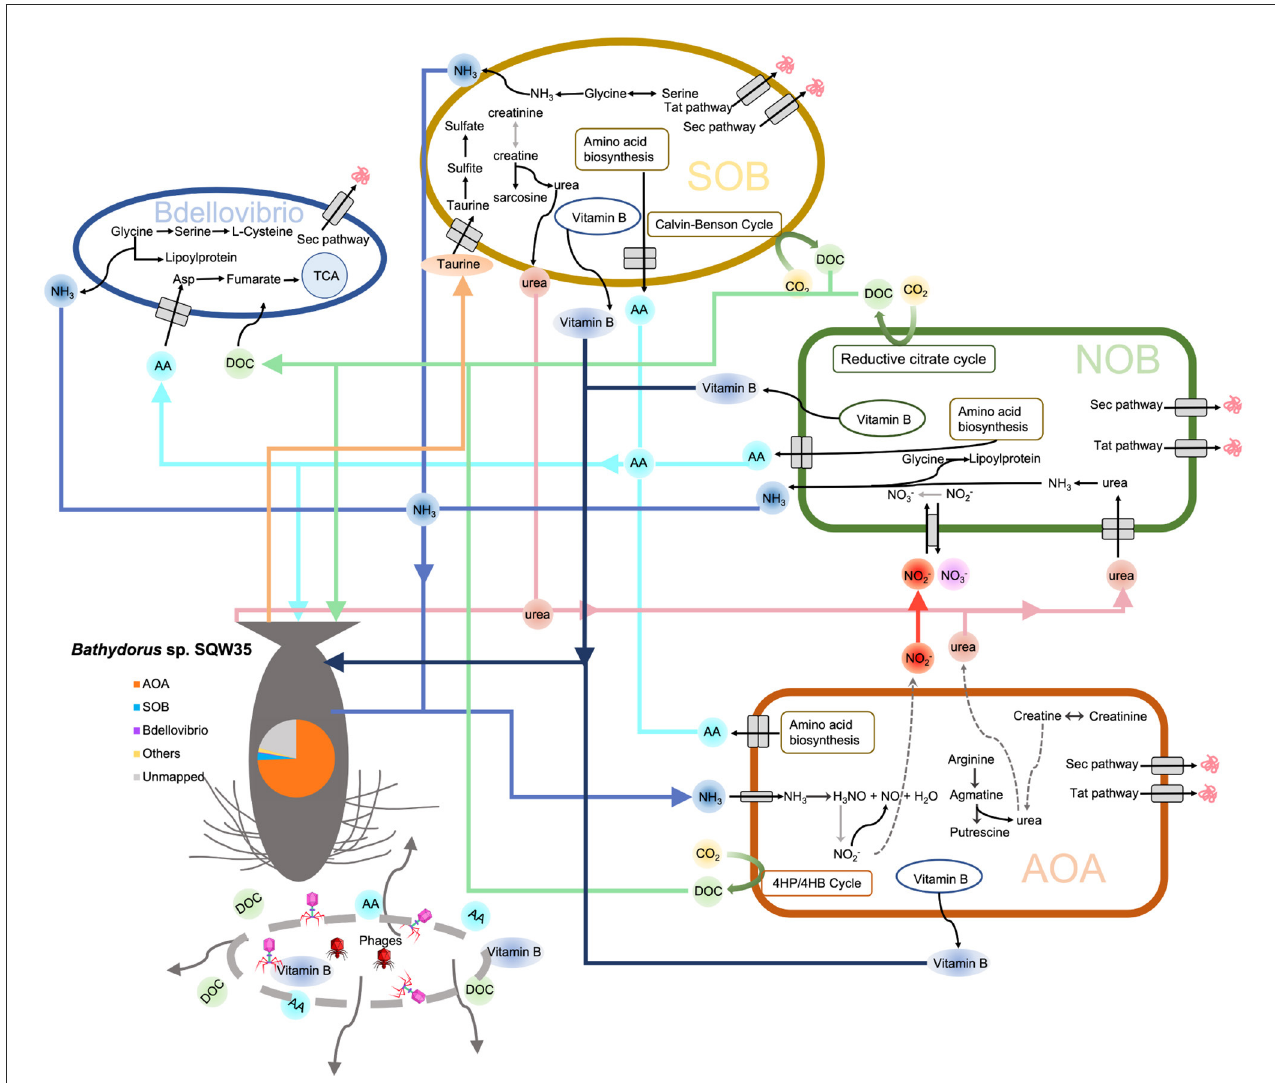
FIGURE6 Metabolic diagram of the symbiotic consortium in Bathydorus sp. SQW35. Solid lines refer to the metabolic pathways in which > 50% of genes/enzymes were identified, and dash lines indicate missing key genes/enzymes. The pie chart shows the relative abundance of the main symbiotic MAGs in the sponge